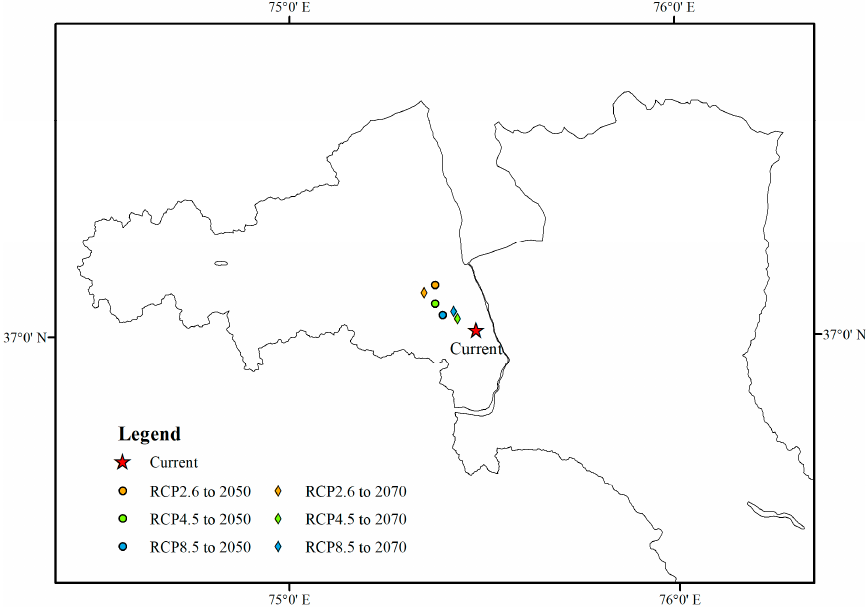
Figure 4. The proportion of suitable habitat area for Siberian ibex at different elevation gradients in Taxkorgan Nature Reserve under current and future climate scenarios.